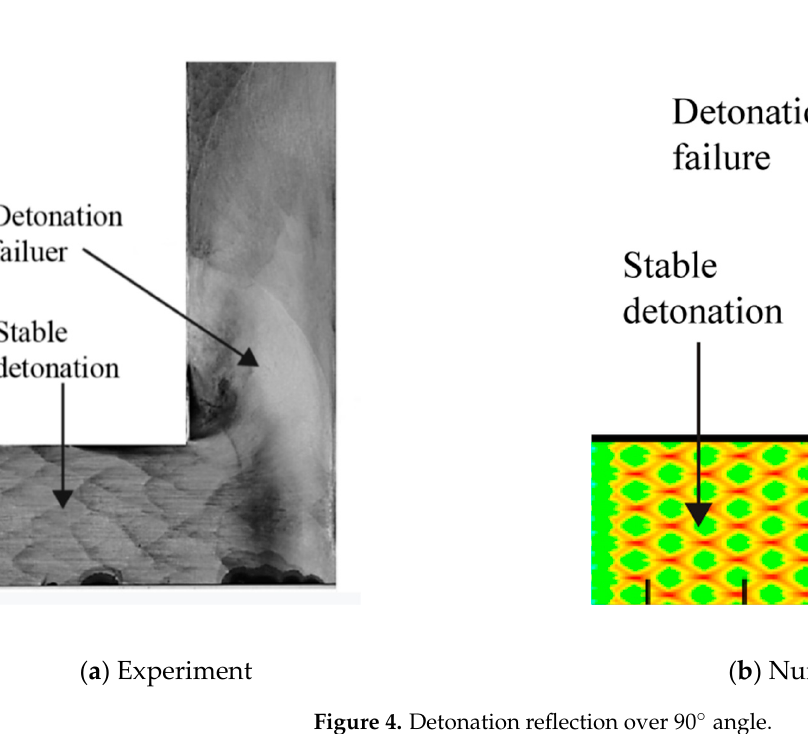
Figure 4. Detonation reflection over 90° angle.